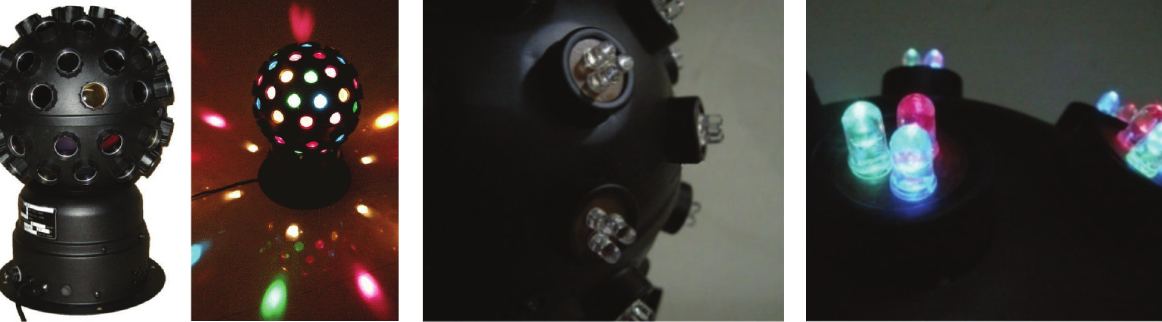
Figure 1: Rotating neon light [2].